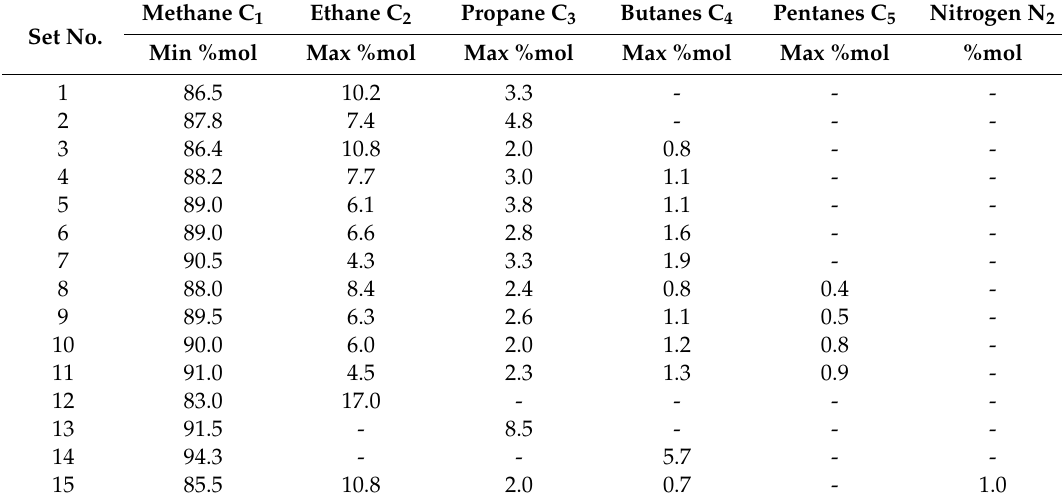
Table 7. Limit contents of methane and other components for methane number equal to 70. Set